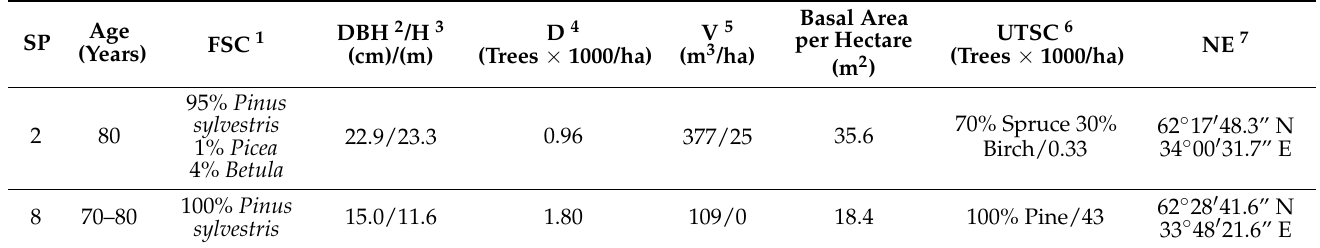
Table 1. A summary of the sample plots and model trees used in the